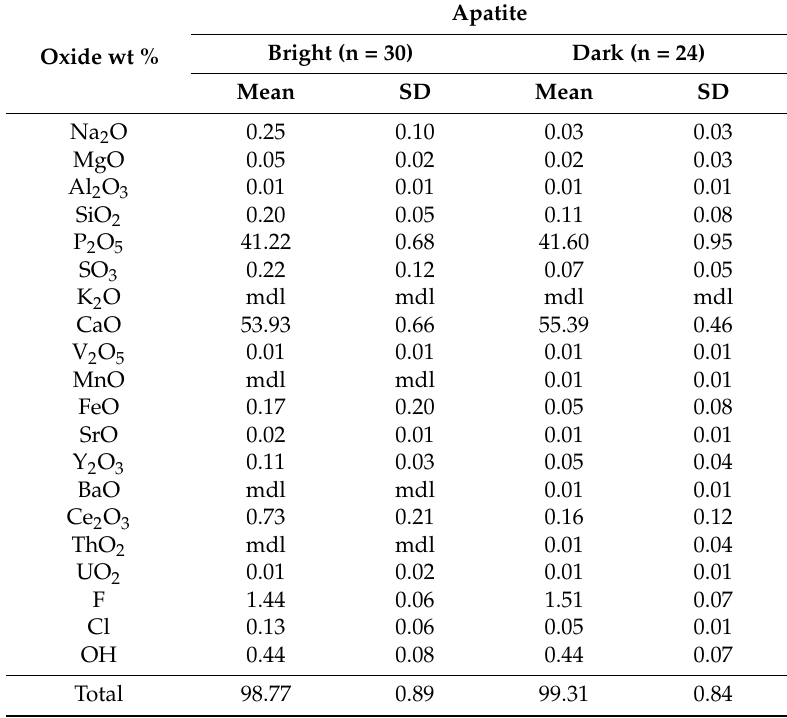
mdl = Minimum detection limit, SD = Standard deviation.